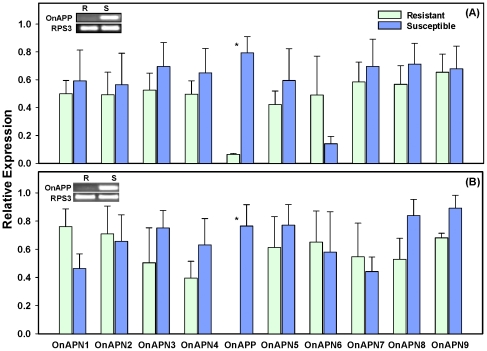
Expression profiles of 10 aminopeptidase-like genes in the larvae of Cry1Ab resistant and susceptible strains of European corn borer.Expression data was generated from two pairs of resistance and susceptible strains: (A) RSTT-R and Europe-S and (B) SKY-R and KY-S. Bars represent relative expression for a particular gene for resistant and susceptible ECB strains based on real-time PCR values. There were three biological replications and two technical replications. Asterik (*) indicates the significant difference at p value <0.01. Gel picture for RT-PCR for the OnAPP gene is given in the upper left corner. RPS3 gene was used as a reference gene.